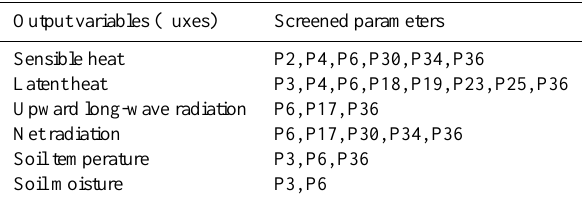
Table 2. Screened parameters of CoLM in A’rou Station (Li et.al.,